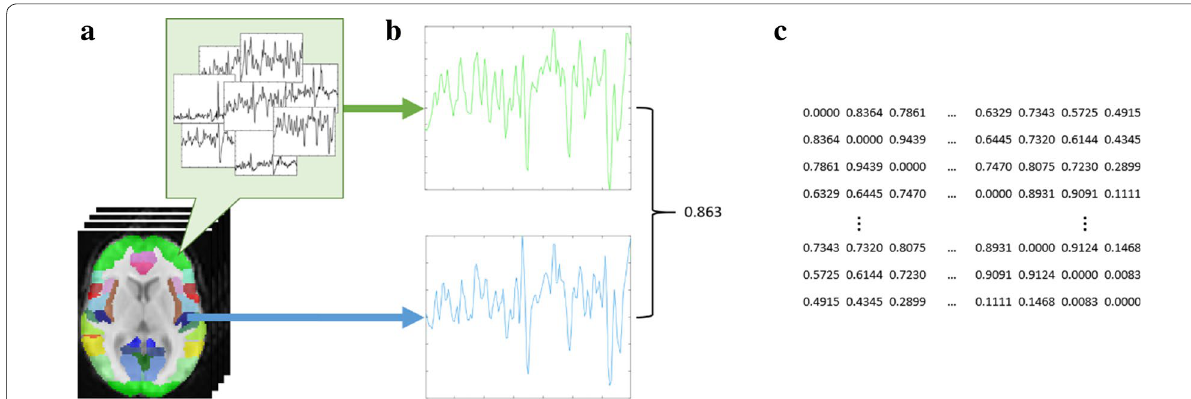
Fig. 2 Functional connectivity networks are created by grouping voxels in the brain using parcellations: a voxels are grouped by anatomical regions from a predefined parcellation; b all the temporal signals in a region are summarised into a representative signal, and then the coactivation is calculated for each pair of regions; and c the coactivation values are formatted into a matrix that can be viewed as a network for analysis and interpretation. Uncertainties arise from this process regarding how well the parcellations fit each subject, heterogeneity in the temporal and spatial data, as well as the loss of spatial information in formatting as a